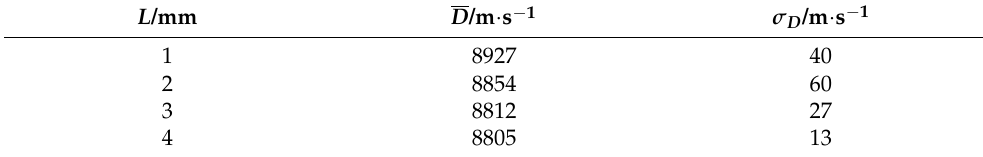
Table 9. Average value and standard deviation of detonation velocity experiment in this paper.